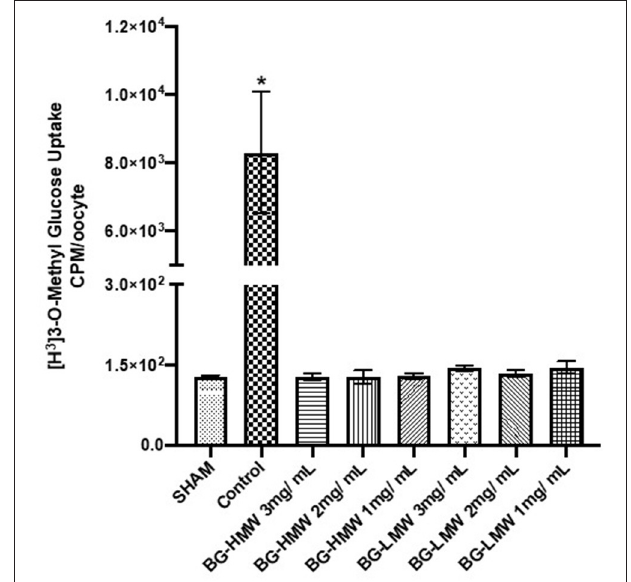
FIGURE 4 | Effect of BG on glucose uptake in oocytes expressing human SGLT1. Oocytes expressing human SGLT1 and oocytes injected with water (SHAM, negative control) were incubated in buffer containing radiolabeled glucose only (control) or buffers containing different amounts barley BG (BG-HMW: 650,000 average molecular weight; BG-LMW: 229,000 average molecular weight). Data are means ± SEM ( n = 10–12 oocytes per treatment). *Significantly different from all other treatment groups p <